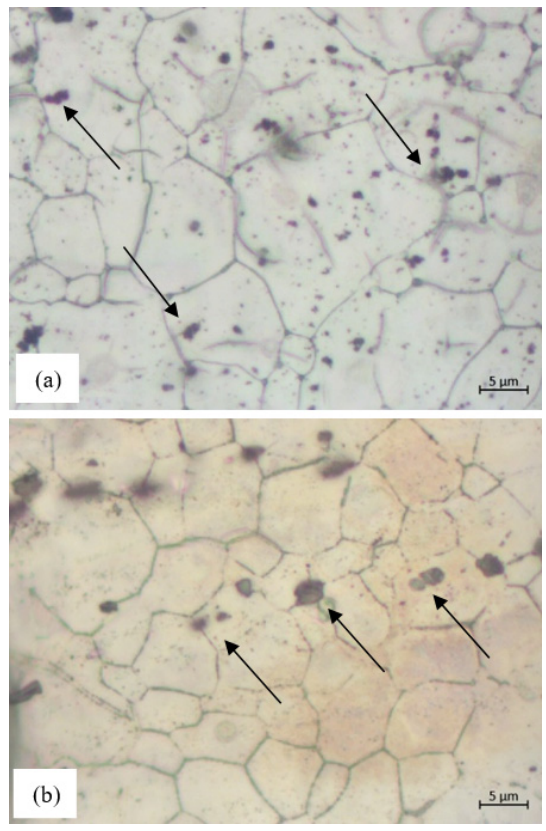
Figure 3. Original microstructure of Mg AZ31B in extrusion condition in (a) Transversal and (b) Longitudinal directions